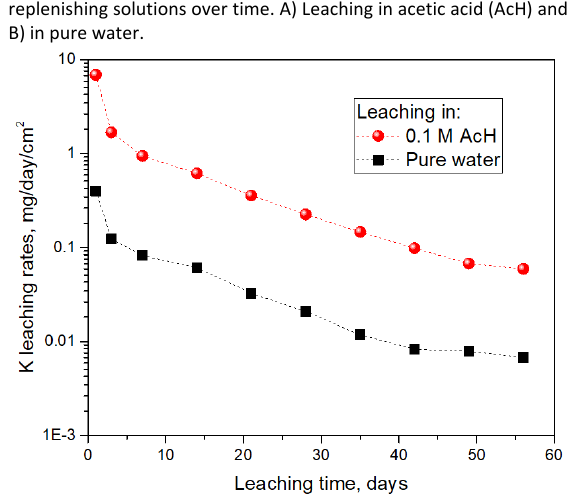
Figure 4. Potassium leaching rates calculated from results in Figure 3, by normalizing the concentration (expressed in mg per 100 mL of employed leaching volume) per time interval and specimen’s leaching surface